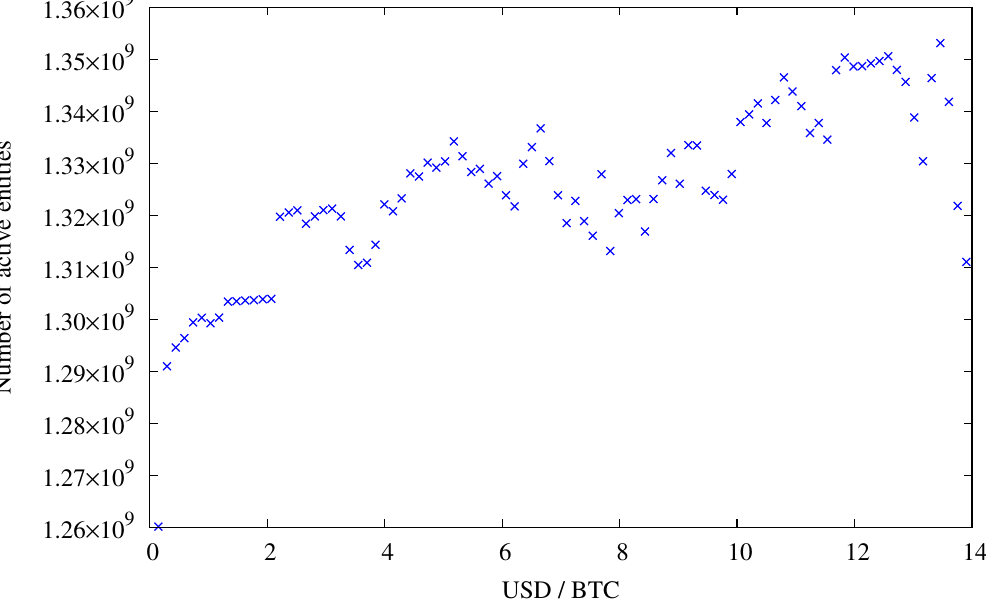
Figure 7. Price per bitcoin and active entities. Data points for exchange rates above 14 USD were omitted because for higher exchange rates not enough data points are available (see Figure 6a), i.e ., an exchange rate of 14 USD or more was reached for 52 days